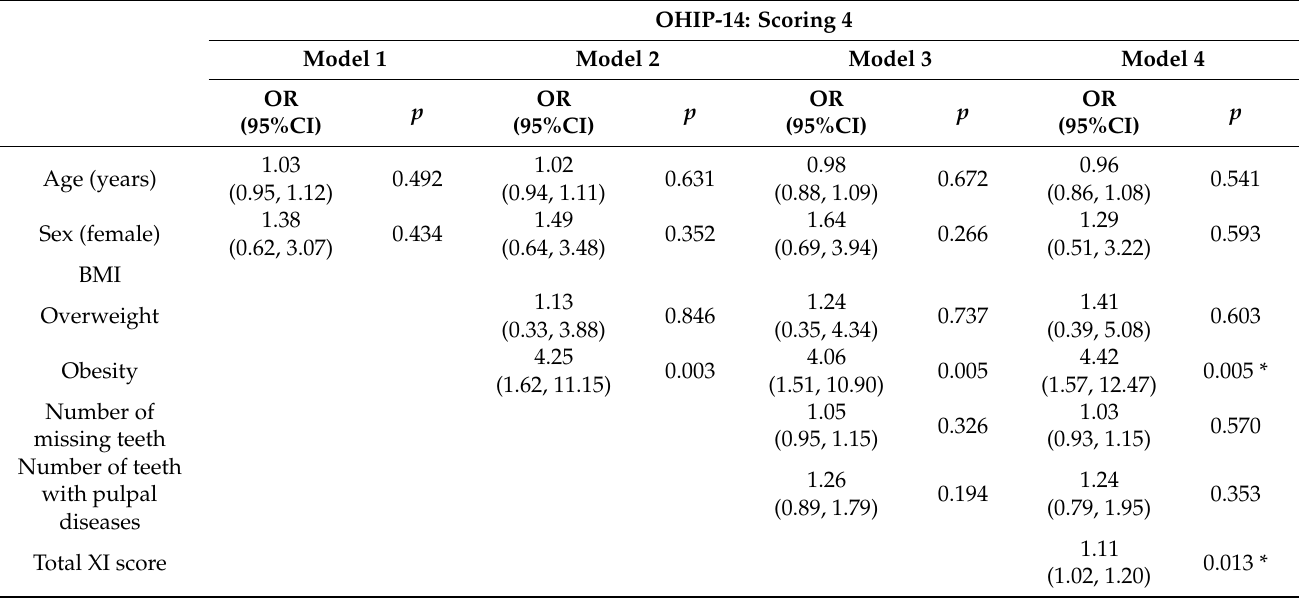
Table 4. Logistic regression analysis for oral health-related quality of life (OHRQoL) and associated factors (odds ratio (95% confidence interval)) (n =